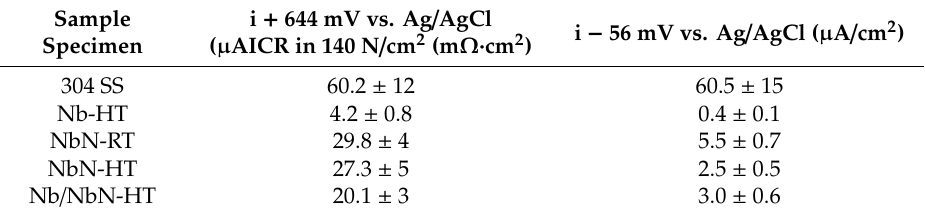
Table 10. The interfacial contact resistance of bare and coated 304 SS at compaction force of 140 N / cm 2